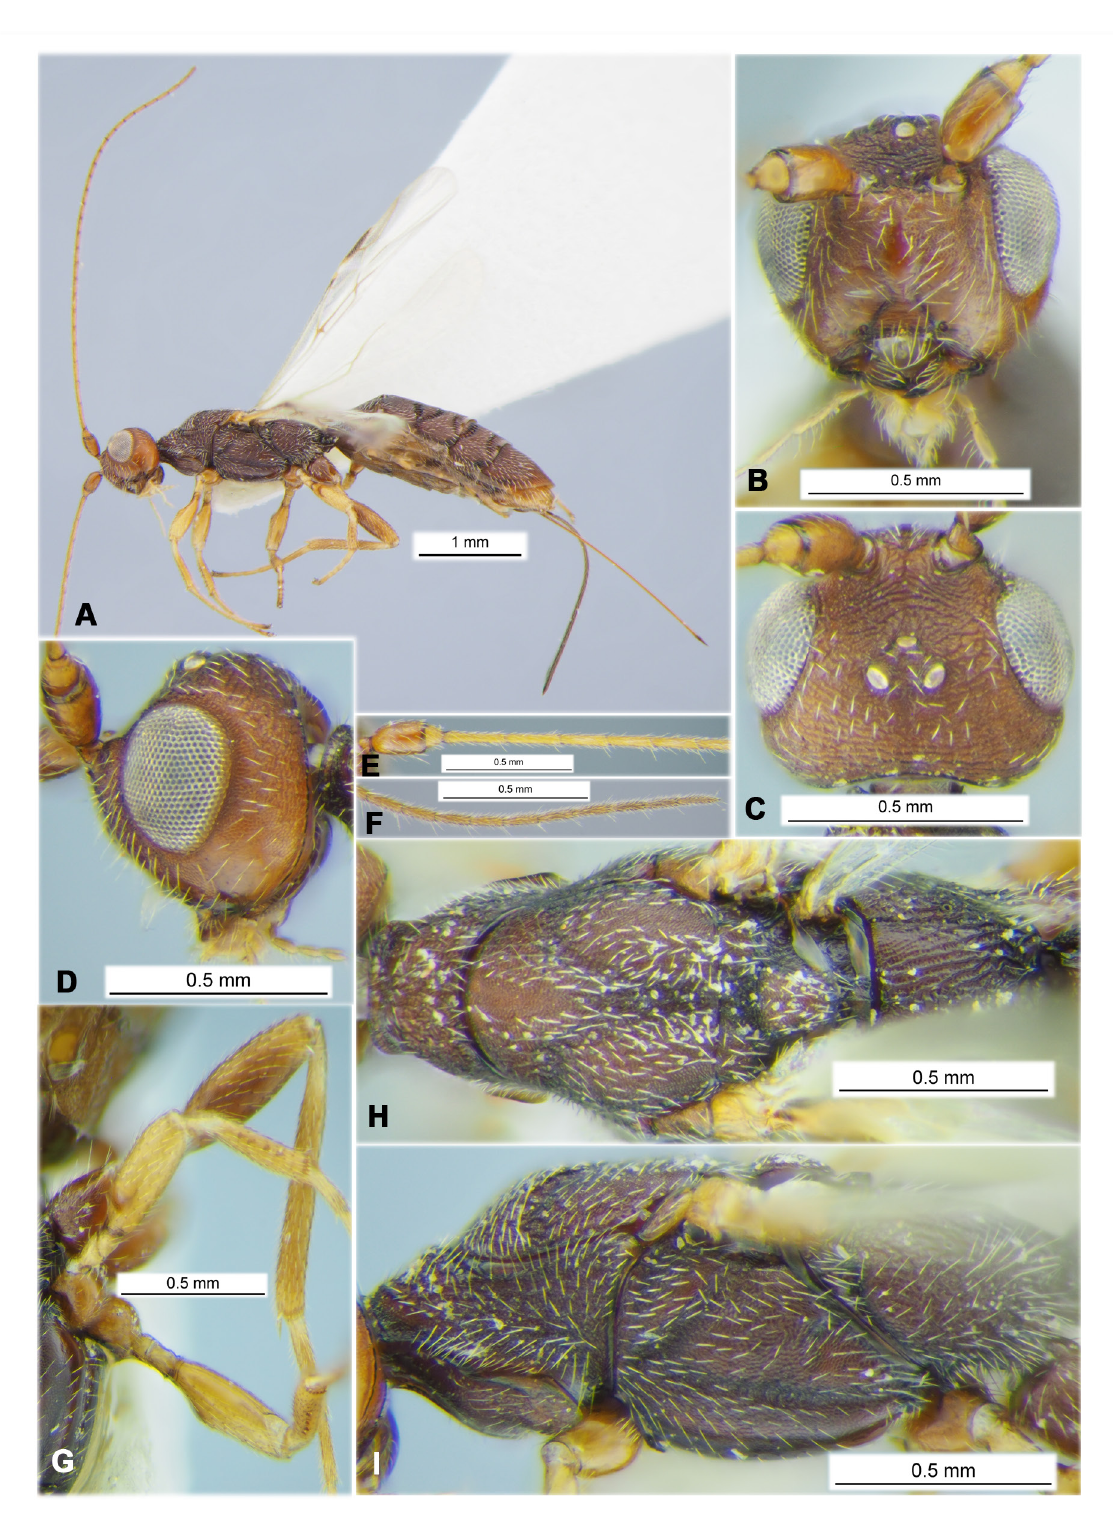
Fig. 49. Rhaconotus ( Rh. ) brevicellularis Belokobylskij sp. nov., holotype, ♀ (RMNH). A . Habitus, lateral view. B . Head, front view. C . Head, dorsal view. D . Head, lateral view. E . Basal segments of antenna. F . Apical segments of antenna. G . Hind leg. H . Mesosoma, dorsal view. I . Mesosoma, lateral